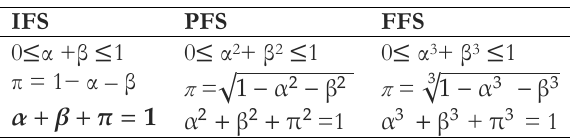
Table 1. IFS, PFS and